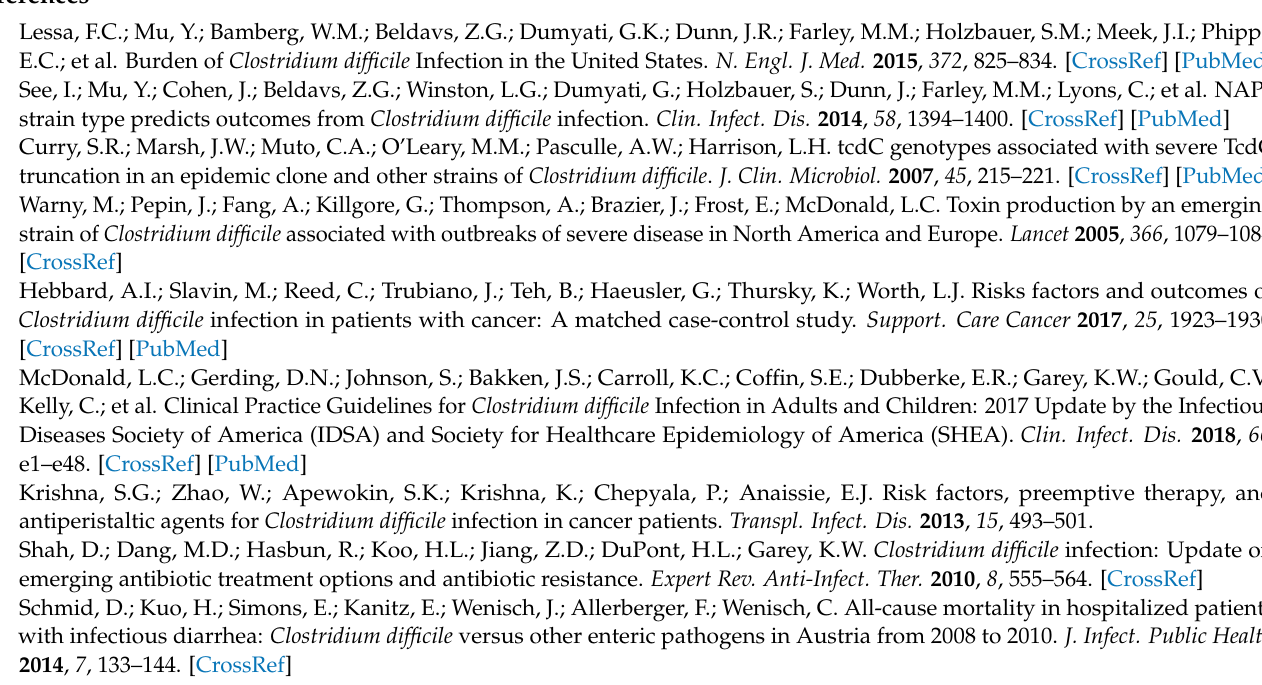
Table S3: Effects of Fe 3+ on the MICs of vancomycin in different C. difficile strains, Table S4: Effects of Fe 3+ on the MICs of fidaxomicin in different C. difficile